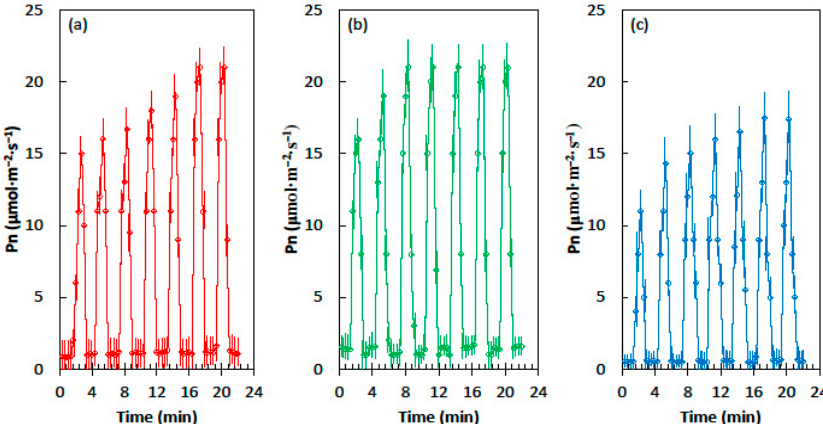
Figure 2. Net CO 2 assimilation (Pn) of the Zea mays leaves in response to the alternating shade flecks with a photosynthetic photon flux density (PPFD) of 55 µ mol · m − 2 · s − 1 and the light flecks with a PPFD of 800 µ mol · m − 2 · s − 1 . The experimental leaves were grown in ( a ) homogeneous 62% sunlight exclusion under a shade screen, ( b ) heterogeneous 62% sunlight exclusion under a slat-house, or ( c ) full sun. Each marker is a mean of four replications.